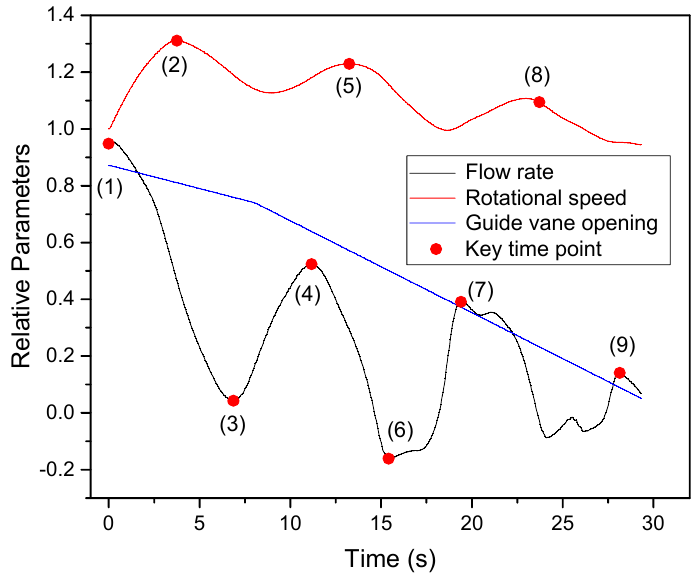
Figure 2. The operating parameters and 9 key time points of the PT unit during load rejection. The pressures at the spiral case inlet and the draft tube outlet calculated by 1D simula- tion are shown in Figure 3. The pressure values at different moments are set as the inlet and outlet boundary conditions for the 3D flow calculation.